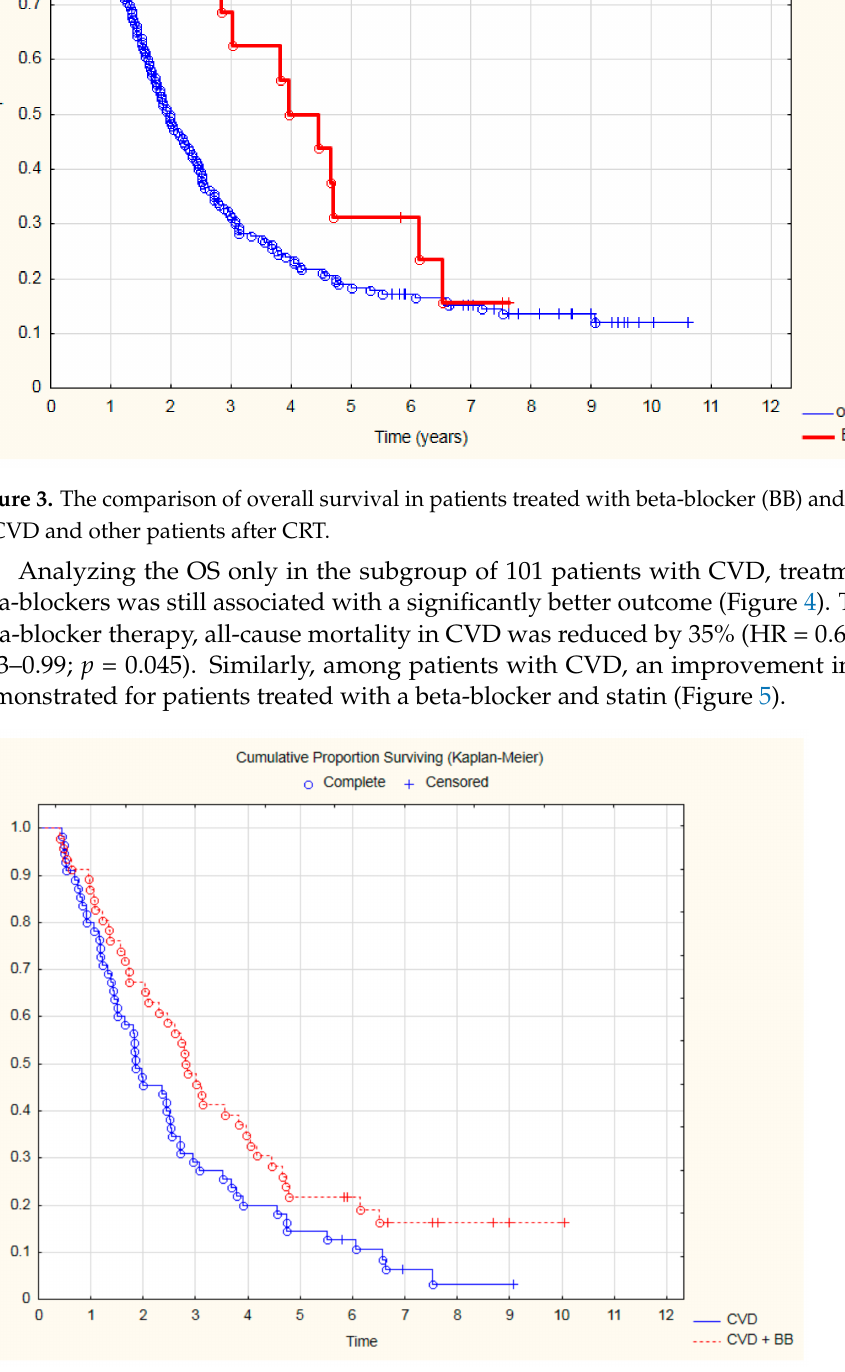
Figure 4. The comparison of overall survival among 101 CVD patients treated with beta-blockers (BB) or not after CRT ( p = 0.04,